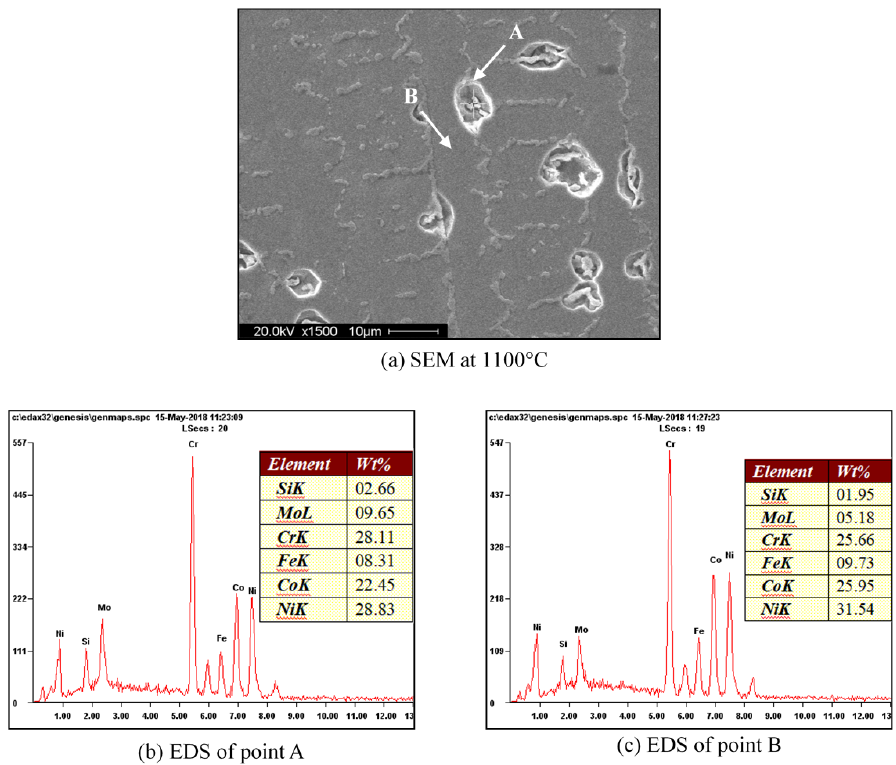
Figure 3. SEM and EDS of CoNiCrMo alloy for 1h at 1100°C solid solution treatment.